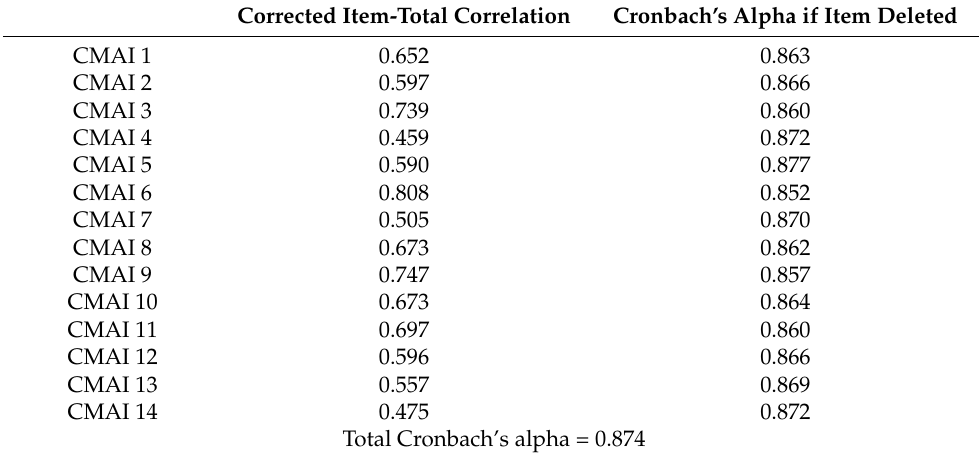
Table 3. Internal reliability for C-CMAI-SF